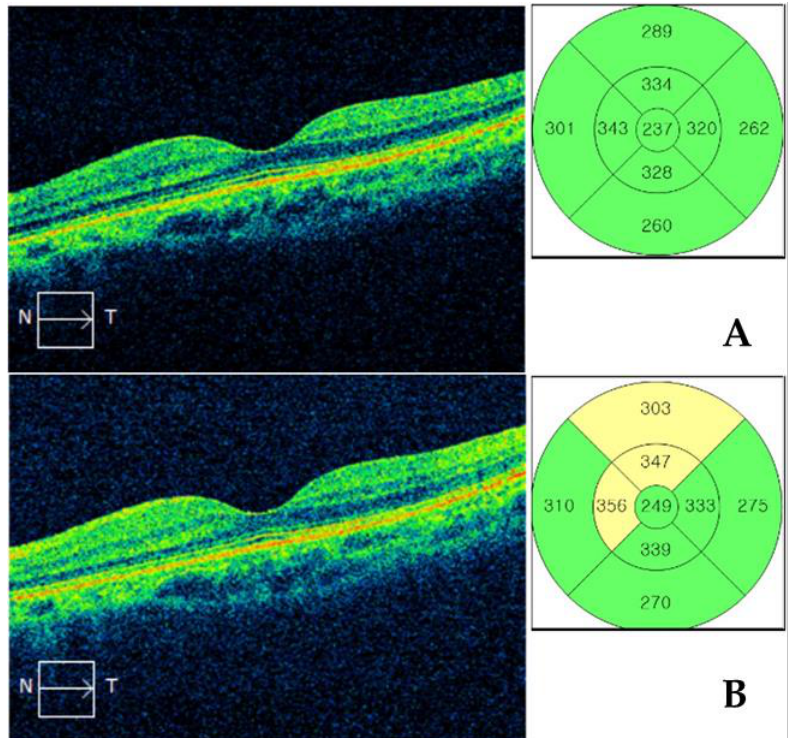
Figure 1. Spectral domain optical coherence tomography macular cube scan. Nine macular thickness values corresponding to the Early Treatment of Diabetic Retinopathy Study (ETDRS) areas were used in the analyses. The three concentric circles in 6 × 6-mm scans had diameters of 1, 3, and 6 mm; each ring (inner and outer) was divided into four quadrants (superior, nasal, inferior, and temporal). ( A ) Preoperative and ( B ) postoperative images of the same representative patient.